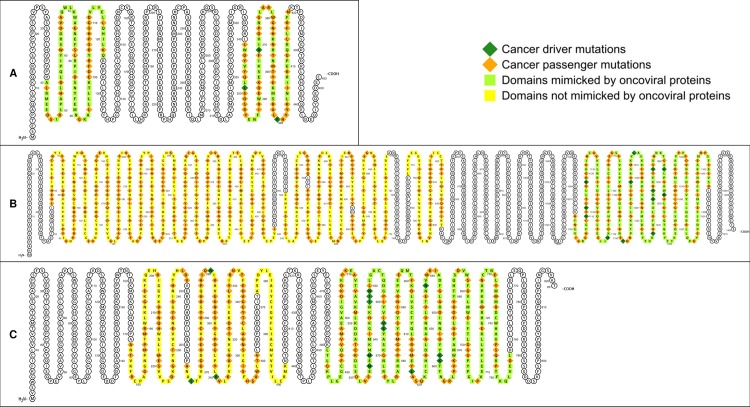
Oncoproteins having no oncovirus-targeted domain (OVTD) but at least one oncoviral homology domain (OVHD), where driver mutations are either exclusively found or enriched.(A) driver:passenger ratio in oncovirus-mimicked PF00178 and PF02198 domains of ETV6 is higher than the mean driver:passenger ratio for all oncoproteins; (B) driver mutations are exclusively found in oncovirus-mimicked PF07714 domain of MET; (C) driver mutations are enriched in oncovirus-mimicked PF07714 domain of FGFR2.